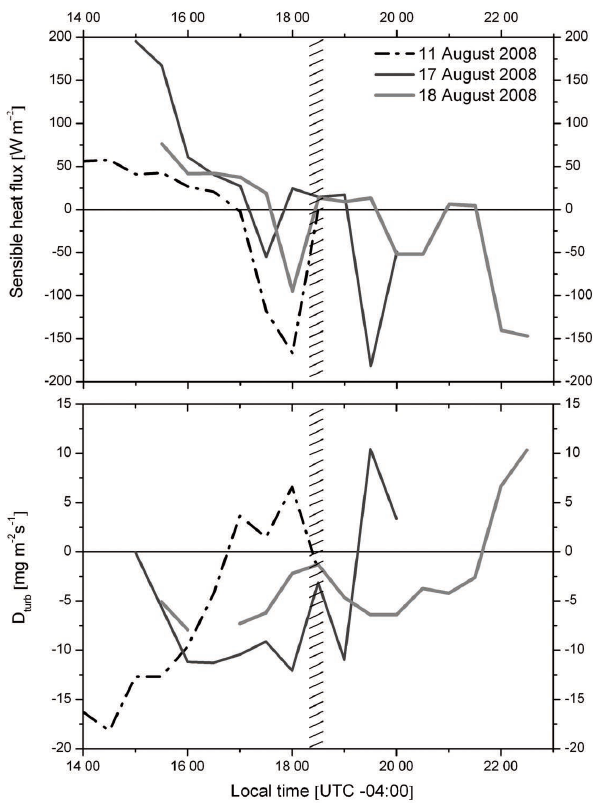
Fig. 2. Temporal evolution of the turbulent fog water flux (lower panel) and the corresponding sensible heat flux (upper panel) for the 3 fog events. The dashed area indicates local sunset.